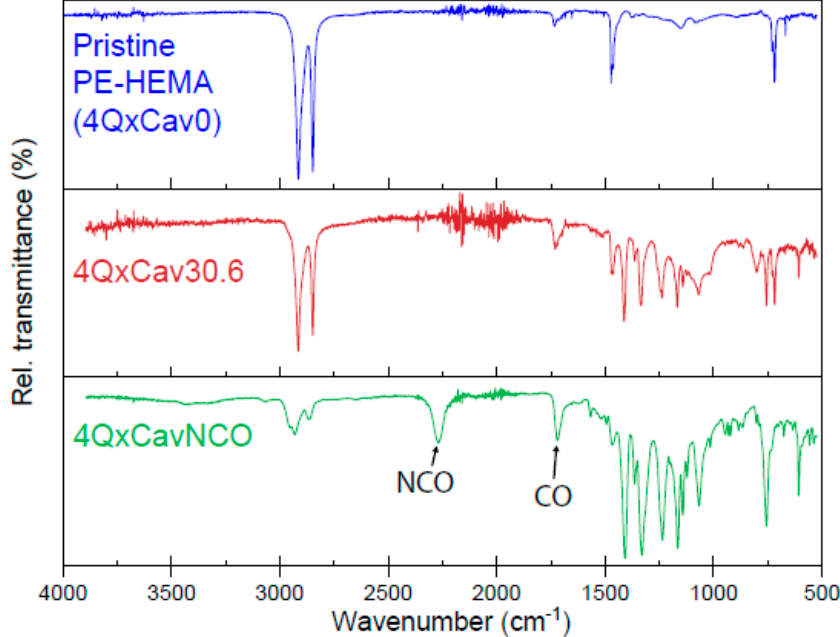
Figure 3. FTIR spectra of pristine PE-HEMA (4QxCav0), 4QxCav30.6, and 4QxCavNCO. Molecules 2019 , 24 , x